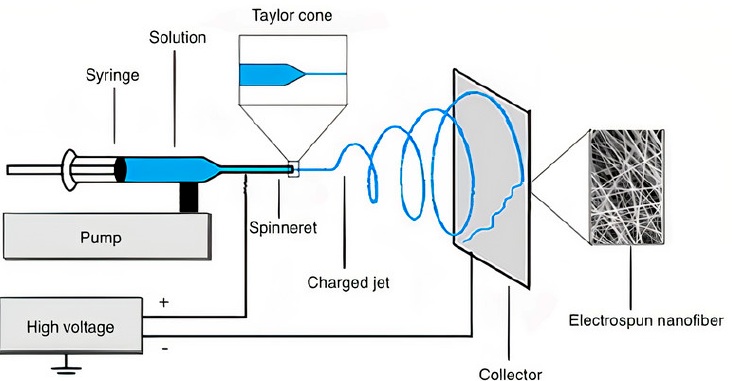
Figure 5. Electrospinning basic set-up. Reprinted with permission from Castillo, L., et al. Electro- spunnanofibers: A nanotechnological approach for drug delivery and dissolution optimization in poorly water-soluble drugs. ADMET & DMPK 8(4). Copyright (2020) International Association of Physical Chemists [119].